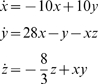
Lorenz oscillator: oscillatory patterns and phase-space representation.Lorenz attractor standard values for the constants were set as follows:
Left panel: Ordinate: oscillatory behavior of variables x (top) and z (bottom). Abscissa: time. Right panel: phase-space representation of the attractor.